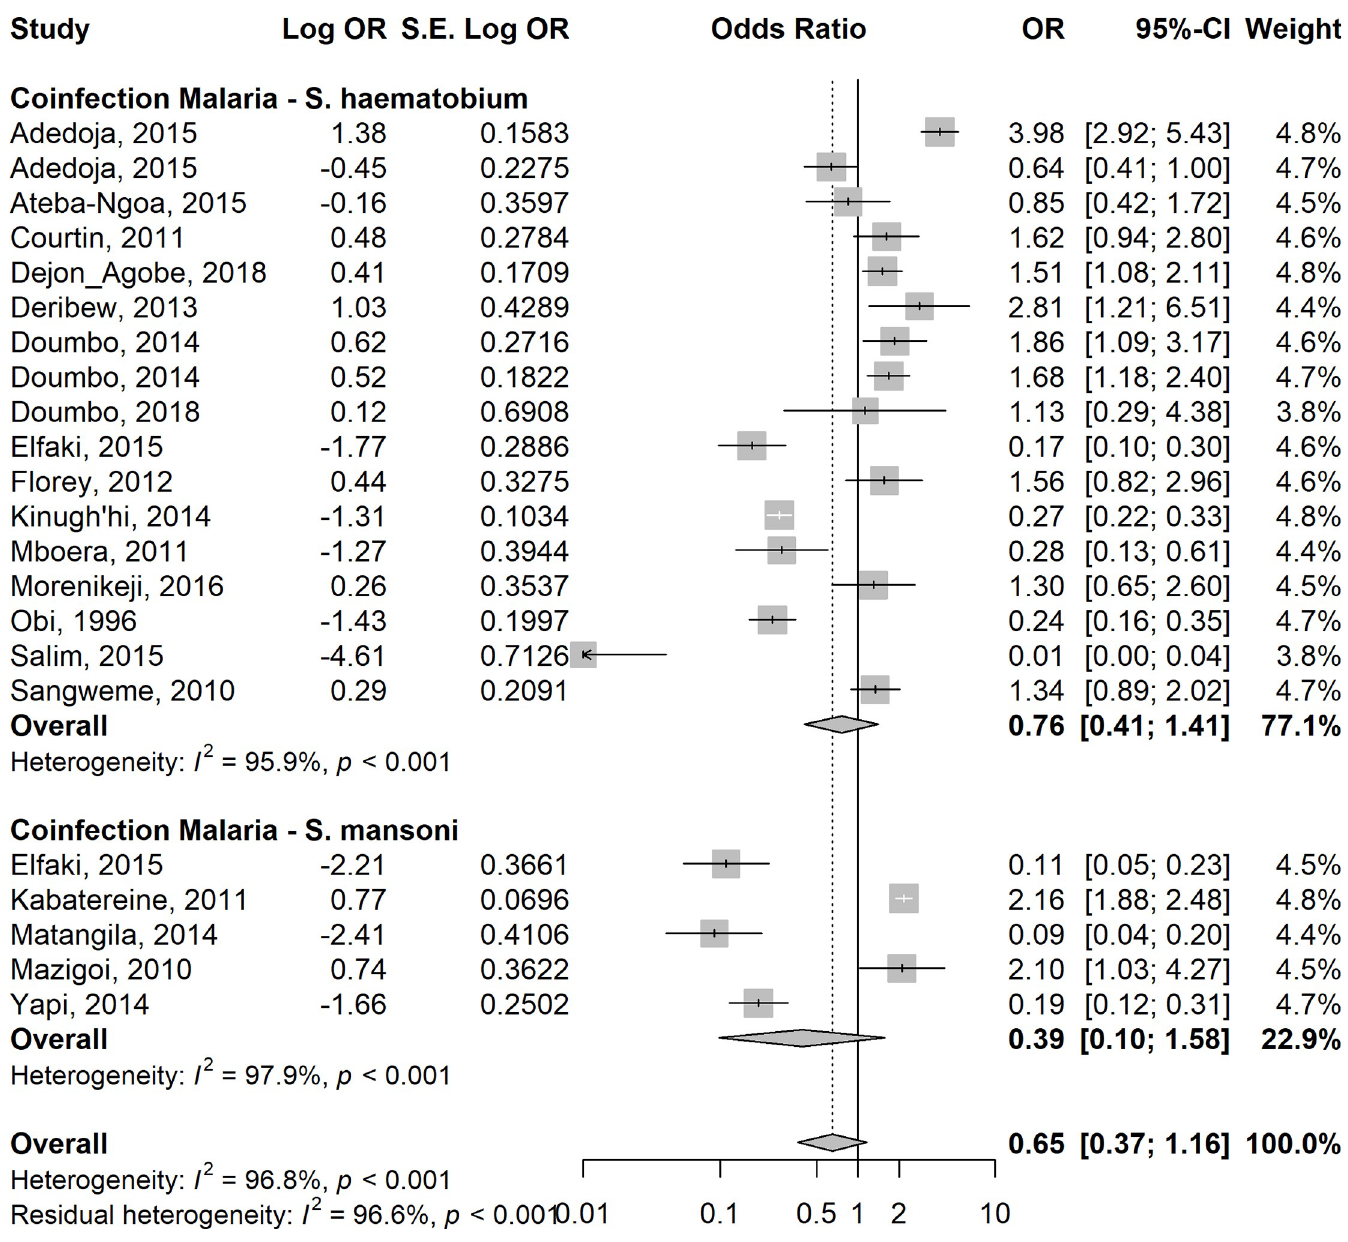
Fig 5. Forest plot showing the risk of asymptomatic/uncomplicated or severe P. falciparum infection in children co-infected with Schistosoma spp compared with children who did not have Schistosoma infection.